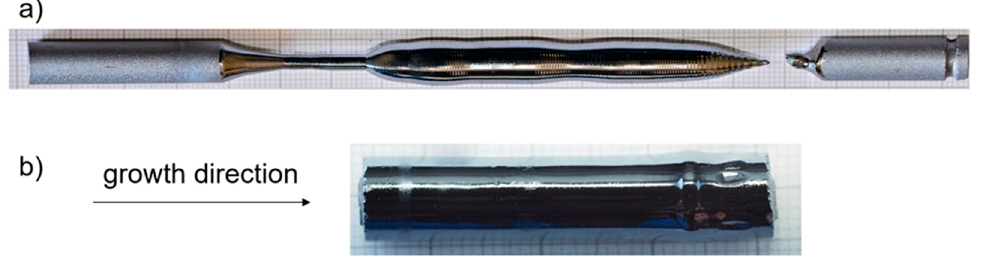
Figure 4. Photographs of two silicon crystals: ( a ) crystal grown with a neck in the double-ellipsoid mirror furnace without silica ampoule; ( b ) crystal containing a SiO 2 skin on the surface grown without a neck in the mono-ellipsoid mirror furnace with silica ampoule.